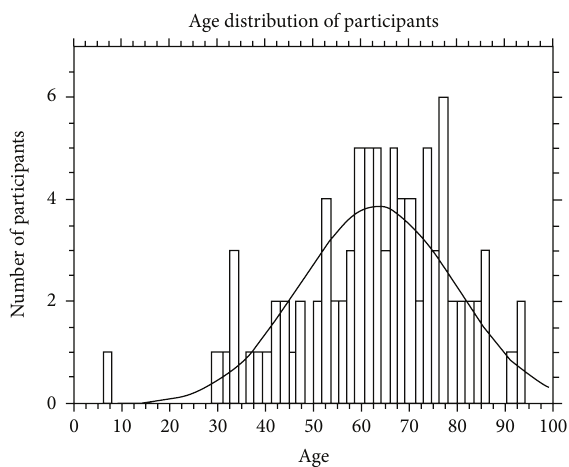
Figure 1: The age distribution of 92 participants who self-identify as having burning hot